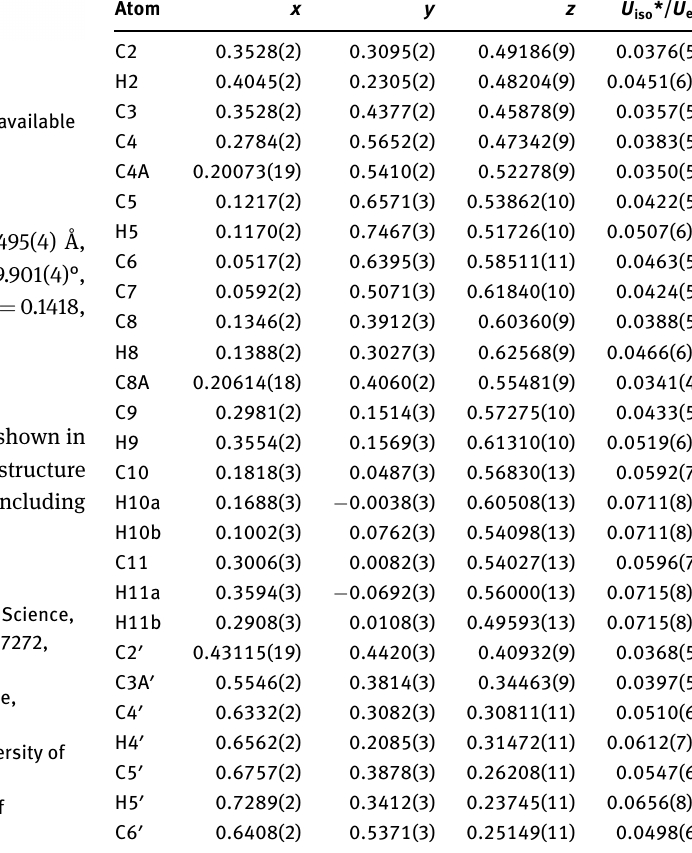
Table 2: Fractional atomic coordinates and isotropic or equivalent isotropic displacement parameters (Å 2